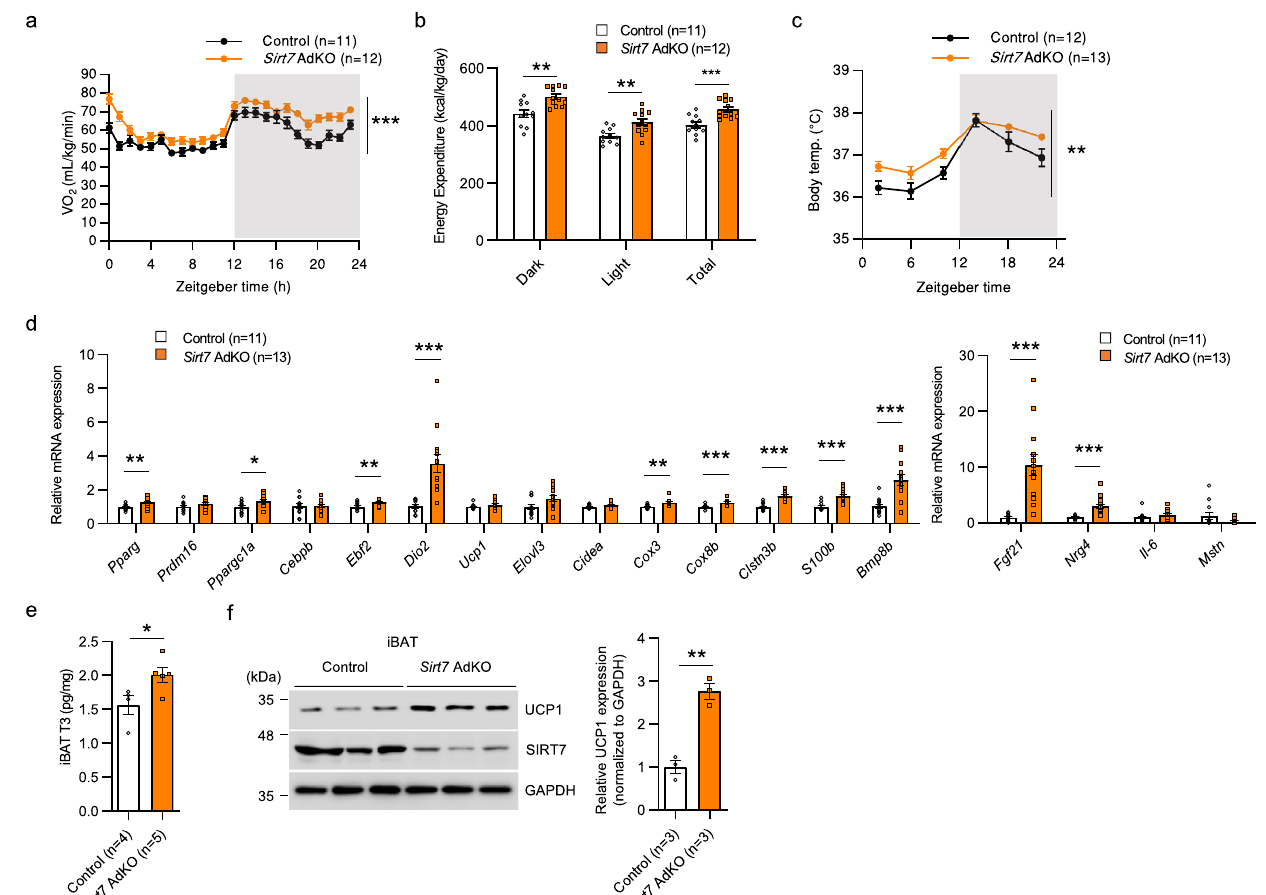
Fig. 4 | SIRT7 de fi ciency in adipose tissue elevates whole-body energy expen- diture and body temperature. a , b Data of indirect calorimetry experiments and body temperaturefrom 12-week-oldmale Adipoq - Cre controland Sirt7 AdKO mice. VO 2 rates ( a ) and energy expenditure ( b ). p =3.7E – 29 in ( a ); p =0.0011 (Dark), p =0.0030 (Light), p =0.0006 (Total) in ( b ). c Oscillation of body temperature in 20-week-old male Adipoq - Cre control and Sirt7 AdKO mice. p =0.0025. d Real-time qPCRanalysisof BAT-relatedgenesiniBATof12-week-oldmale Adipoq - Cre control and Sirt7 AdKO mice. p =0.0089 ( Pparg ), p =0.0239 ( Ppargc1a ), p =0.0026 ( Ebf2 ), p =0.0005 ( Dio2 ), p =0.0010 ( Cox3 ), p =0.0006 ( Cox8b ), p =5.0E – 06 ( Clstn3b ),